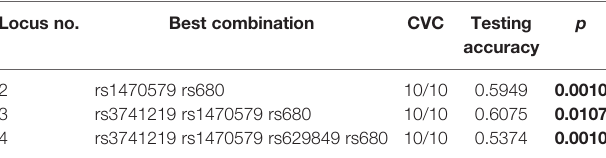
Bold indicated signi fi cant statistical